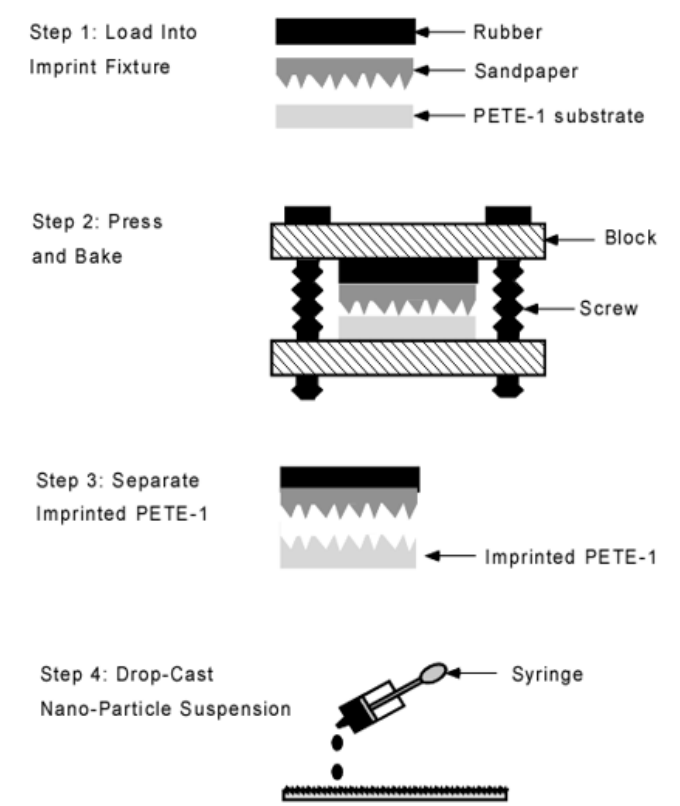
Figure 2. Schematic flowchart of the imprint process. Portions enlarged for clarity.